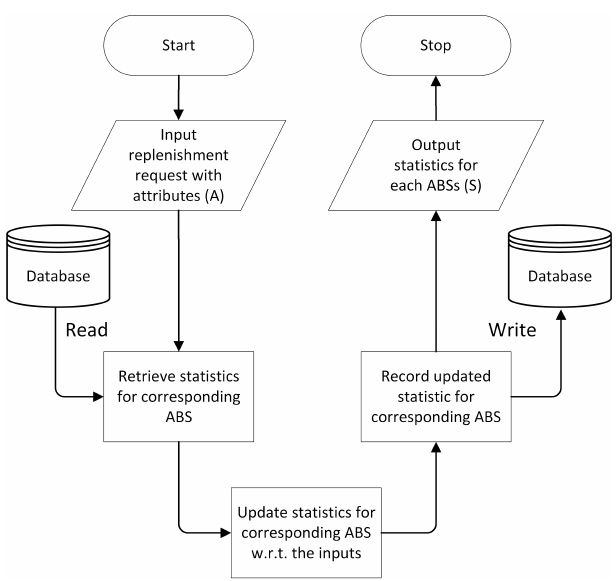
Figure 5. Flowchart for replenishment request scheduler